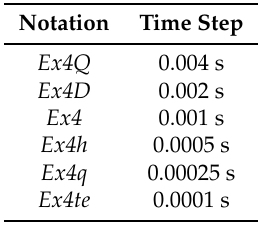
Table 2. A summary of the time steps